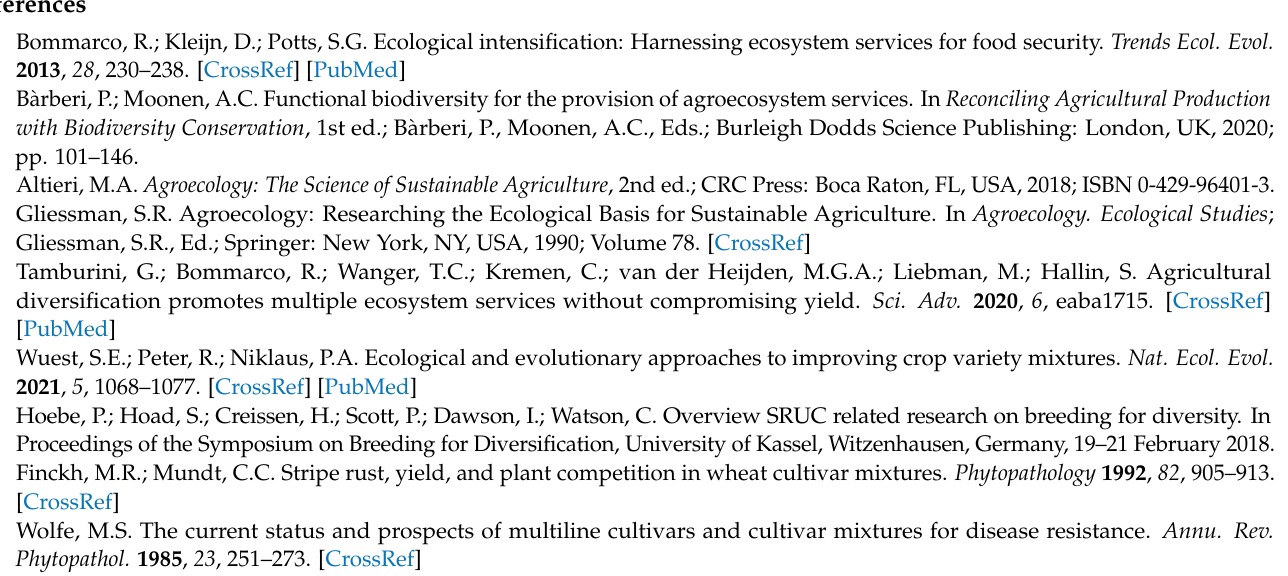
Figure A1. Average standard error (expressed as the output of the linear model) for each treatment over the three years of the experiment (Ne = Nera, Ro = Robin, Sc = Screziata, Tu = Turca). The standard error of the pure stands has a higher volatility than that of the mixtures. In detail, the standard error of the pure stands spans from 6 to 13, whereas that of the mixture of two cultivars is from 6.6 to 8.6, one of the mixtures of three cultivars from 7.3 to 9.9, finally, the mixture of four cultivars shows a value of 7.4. These values provide information on the reliability of mixtures’ performance (in terms of yield stability) compared to the pure stands.